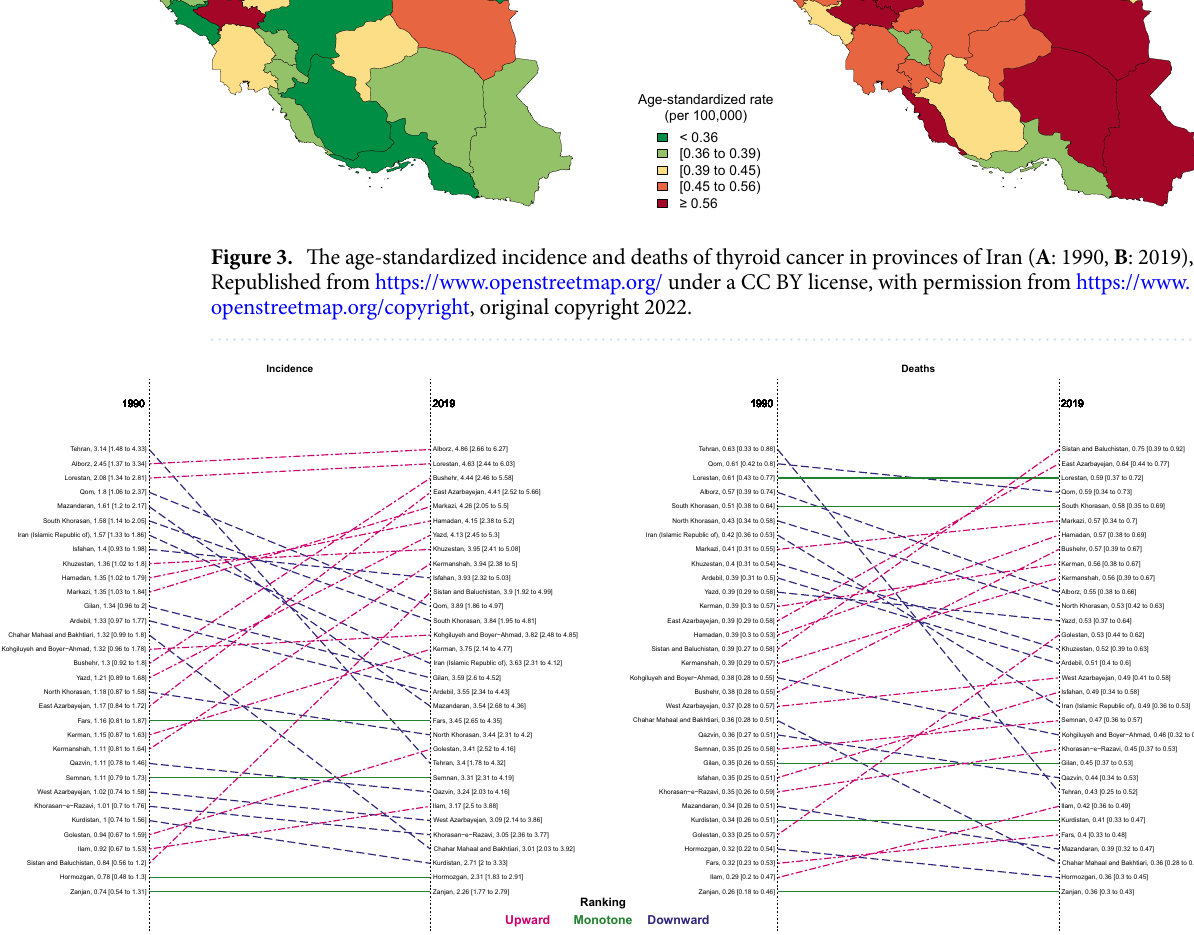
Figure 4. The changes in the thyroid cancer age-standardized incidence and deaths from 1990 to 2019 in both sexes in provinces of Iran: red arrow indicates upward ranking, blue arrow indicates downward ranking, and green arrow indicates monotone Thyroid cancer deaths. Although there were minimal disparities, thyroid cancer causes relatively low death rates among the provinces of Iran (Fig. 3). In 2019, ASDR ranged from 0.36 (0.30–0.43) (i.e. in Zanjan) to 0.75 (0.39–0.92) (i.e. in Sistan and Baluchistan) (Supplementary Table 1). Despite the fact that ASDR increased in most provinces from 1990 to 2019, the difference between the first and the last rank of ASPR was lower in 1990 (i.e. 0.37 versus 0.39). Among the provinces in which ASDR increased between these years, the extent of change